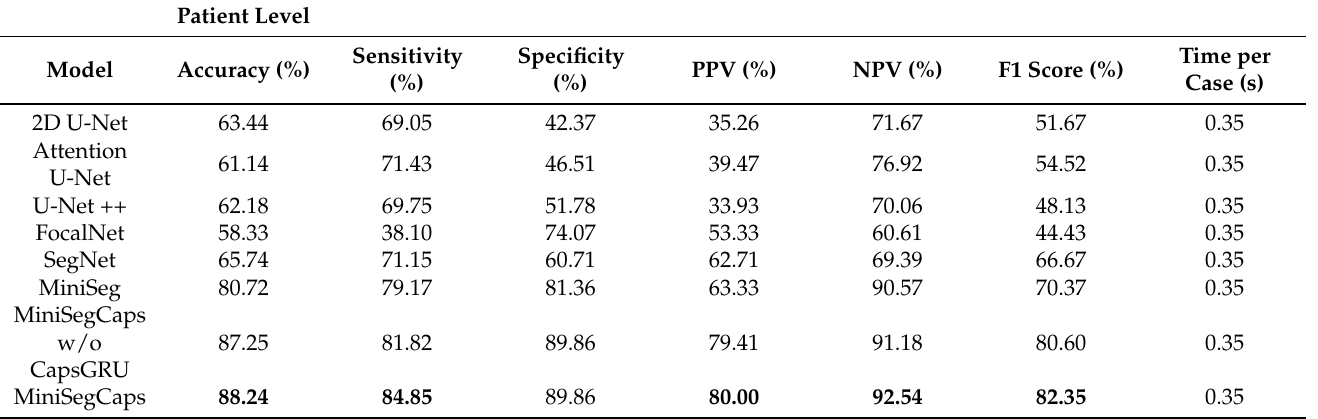
Table 10. Comparison of the patient-level performance between our method and baseline methods in prostate cancer classification on PI-RADS =